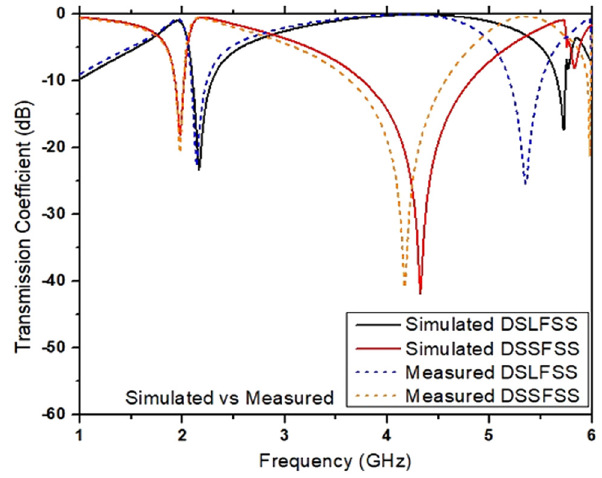
Figure 12: Simulated versus measured transmission coe ffi cients of the CPFSS structure.